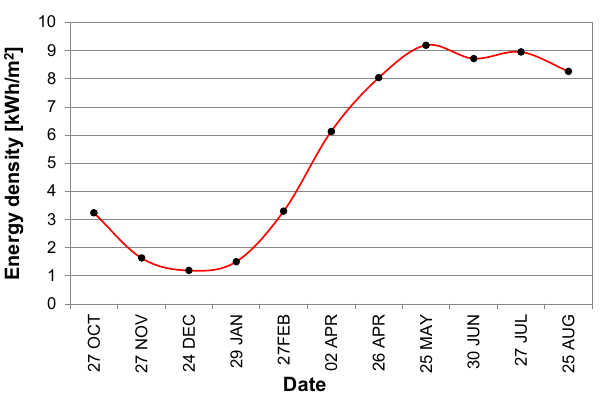
Figure 4. Measured and computed waveforms of power density of irradiation in the location of the photovoltaic installation on selected days.